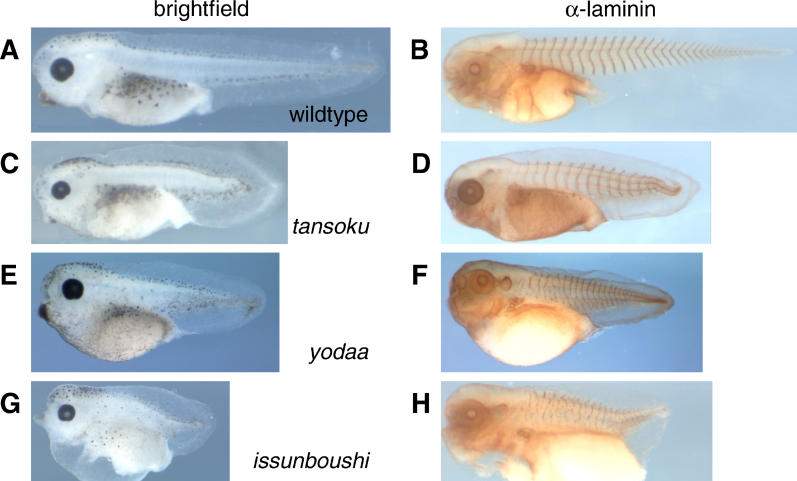
Axis Extension MutationsThe dwarf phenotypes tansoku, yodaa, and issunboushi show relatively normal head and trunk structures, but are defective in tail extension. Anti-laminin immunohistochemistry reveals discrete defects in axial structures, with tansoku ([C] and [D]) displaying a reduced number of relatively well-ordered somites, issunboushi ([G] and [H]) showing highly disordered intersomitic boundaries, and yodaa ([E] and [F]) displaying an intermediate phenotype.